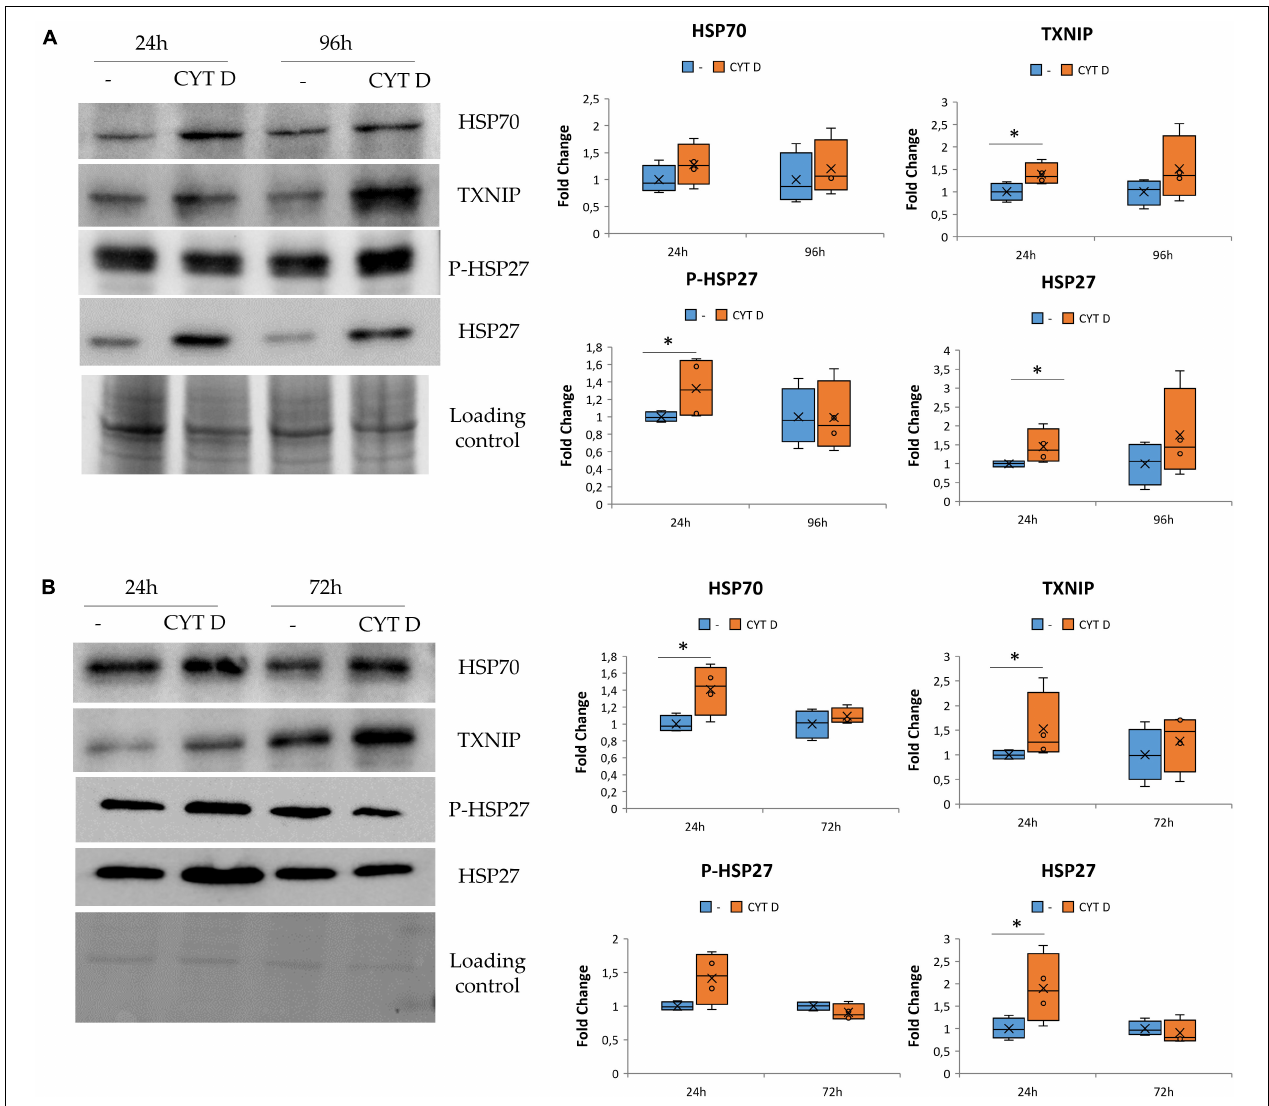
FIGURE 4 | Cytoskeletal remodeling in the presence CYT D and the effect on stress response. Western blots were performed on human endothelial cell from umbilical vein (A) and human dermal microvascular endothelial cell (B) . Antibodies against TXNIP, HSP70, HSP27, and P-HSP27 were used and normalized on control loading. Densitometric analyses are shown next to the respective blots. * P <